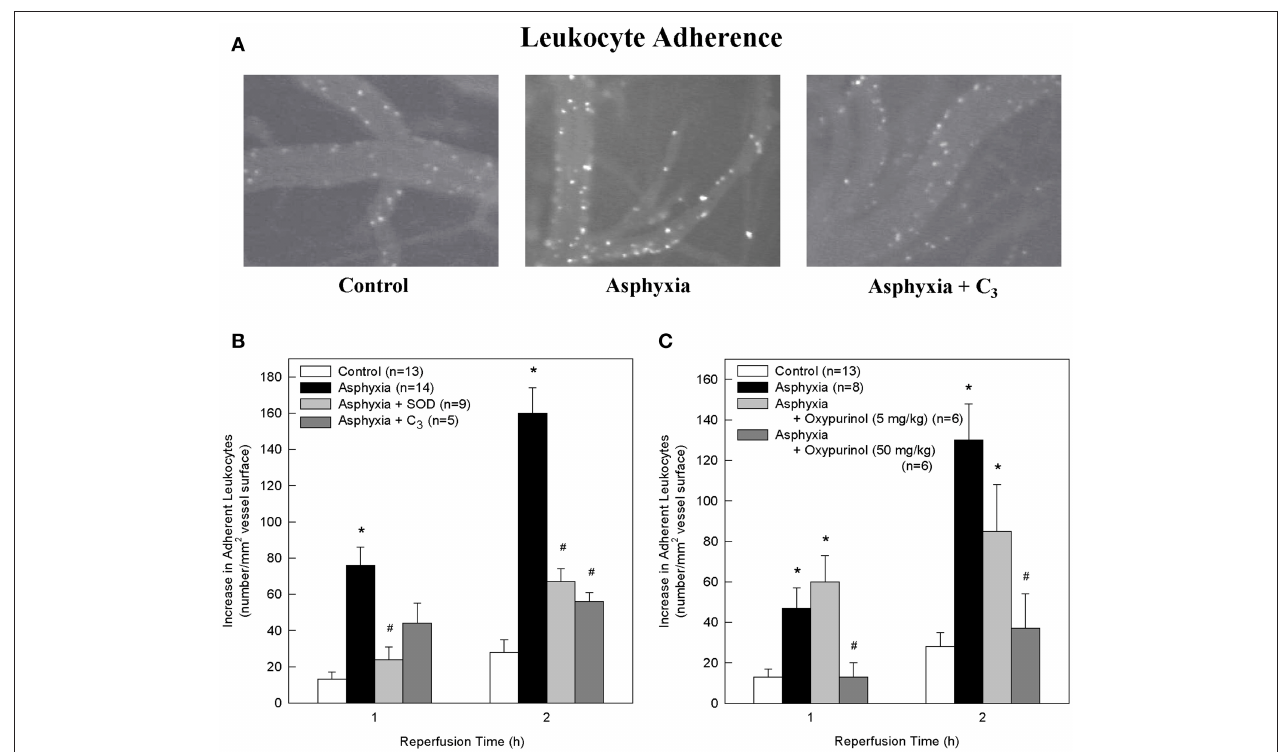
FIGURE 1 | SOD, the SOD mimetic C 3 , and oxypurinol block the asphyxia-mediated increase in leukocyte adherence. (A) Representative images of rhodamine 6G-labeled adherent leukocytes in control animals, asphyxial animals, and asphyxial animals administered C 3 , at 2h of reperfusion. (B) Animals induced with asphyxia and concomitant window superfusion with aCSF ( n = 14) exhibited a statistically significant increase in leukocyte adherence relative to control animals ( n = 13) at both 1 and 2h of reperfusion. Animals continuously administered 1,000 U/ml SOD at a rate of 50 µ l/min by window superfusion beginning 30min prior to asphyxia ( n = 9) exhibited significantly decreased leukocyte adherence relative to asphyxial animals at both 1 and 2h of reperfusion. Animals continuously administered 300 µ M C 3 at a rate of 50 µ l/min by window superfusion beginning 30min prior to asphyxia ( n = 5) exhibited significantly decreased leukocyte adherence relative to asphyxial animals at 2h of reperfusion. (C) Animals induced with asphyxia without aCSF superfusion across the window ( n = 8) had a statistically significant increase in leukocyte adherence relative to control animals ( n = 13) at both 1 and 2h of reperfusion. Animals administered 50 mg/kg oxypurinol 30min prior to undergoing the asphyxia protocol ( n = 6) exhibited significantly decreased leukocyte adherence relative to asphyxial animals at both 1 and 2h of reperfusion. Animals administered 5 mg/kg oxypurinol 30min prior to undergoing the asphyxia protocol ( n = 6) exhibited no change in leukocyte adherence relative to asphyxial animals at either time point. Values shown (mean ± S.E.M.) represent increases above baseline in the number of leukocytes adherent to cerebral venules after 1 and 2h of post-asphyxial reperfusion. * p < 0.05 vs. control; # p < 0.05 vs.